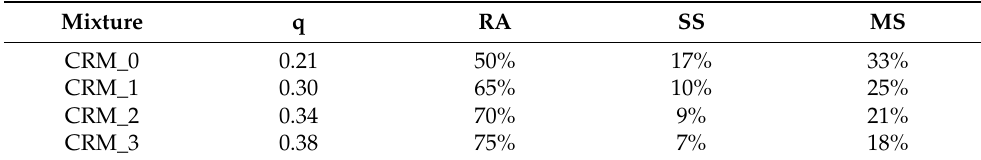
Table 3. Composition of aggregate skeleton of investigated CRMs.